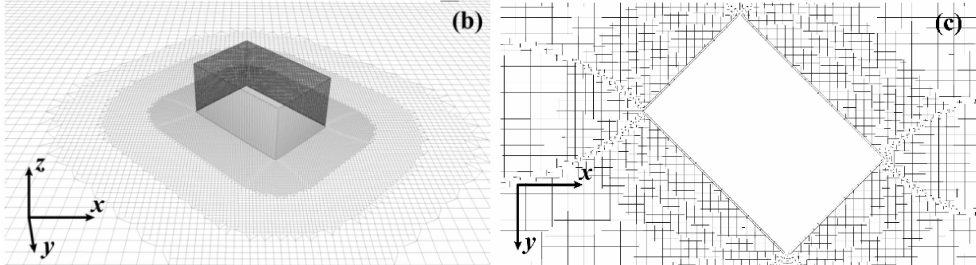
Figure 3. Mesh system of the domain with an isolated building for a 45-degree angle: ( a ) the crosswise slice of the whole domain, ( b ) the mesh of building, and ( c ) the horizontal slice of the building mesh. The x-direction for the streamwise direction, y for the crosswise direction, and z for the vertical